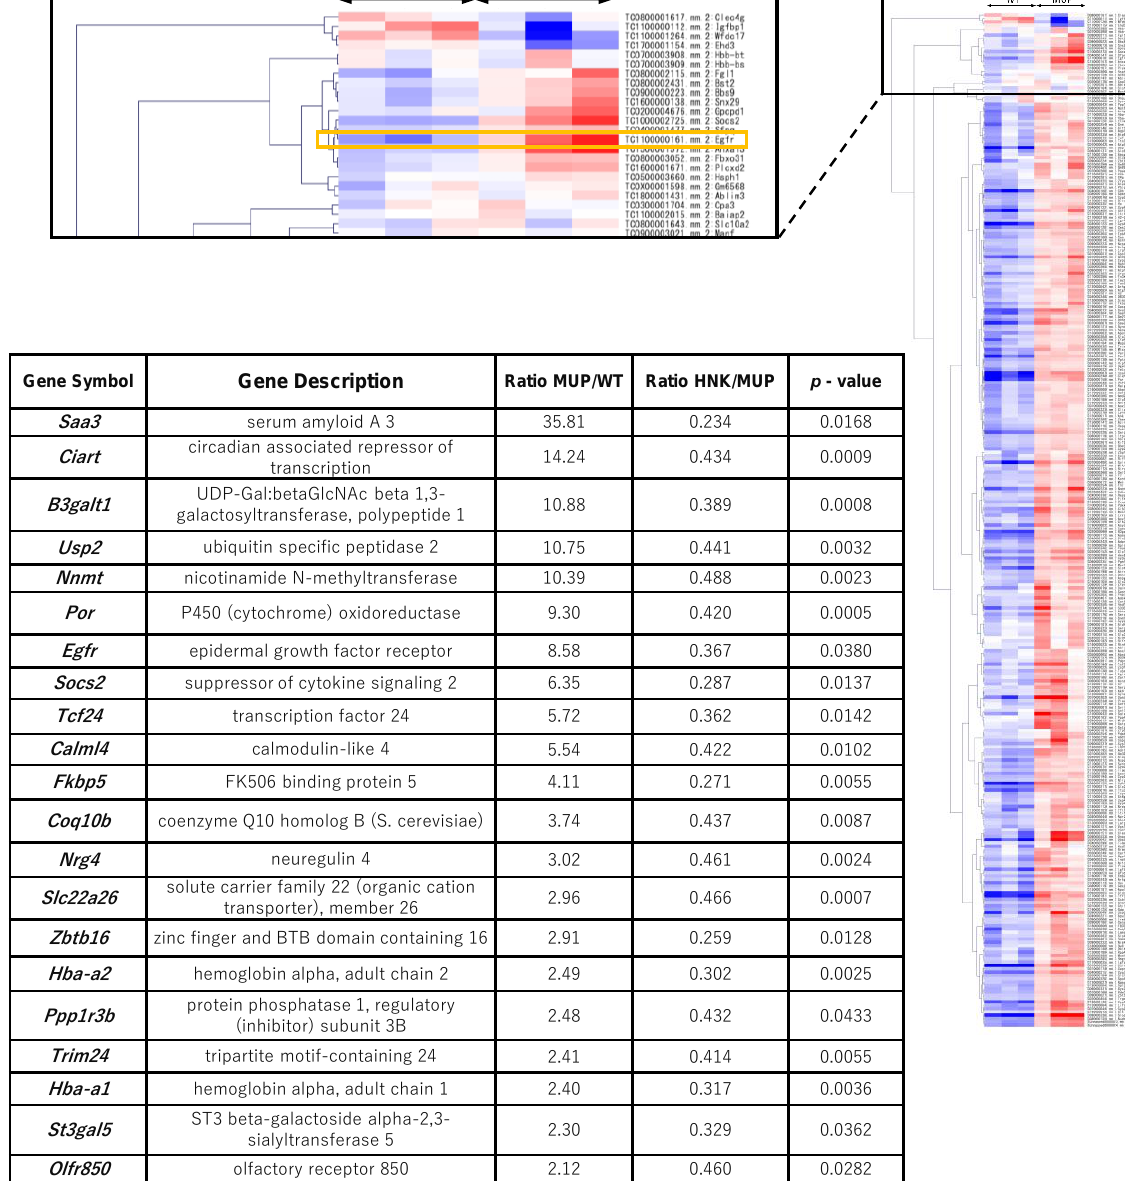
Figure 2. Epidermal growth factor receptor (EGFR) signaling is upregulated in HFD-fed MUP-uPA mouse liver. ( A ) Hierarchical clustering results of differentially expressed genes between HFD-fed MUP-uPA (MUP) and HFD-fed wild-type B6 (WT) mouse livers ( n = 3 per group). The list of genes analyzed here is shown in Table S1. ( B ) A total of 21 genes, including Egfr and Fkbp5 , were upregulated in MUP-uPA mice, and suppressed by HNK-treatment. Notably, FKBP5 is an oncogenic molecular chaperon and oncoprotein that inhibits GR activation